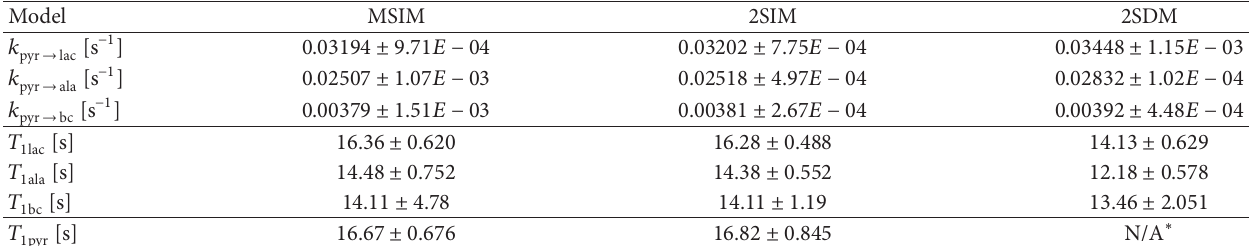
Table 1: Exemplary parameter estimates ( ± standard error) obtained from three different kinetic modeling methods for a 40mM (0.2 mmol/kg) dose of kidney predominant tissue.